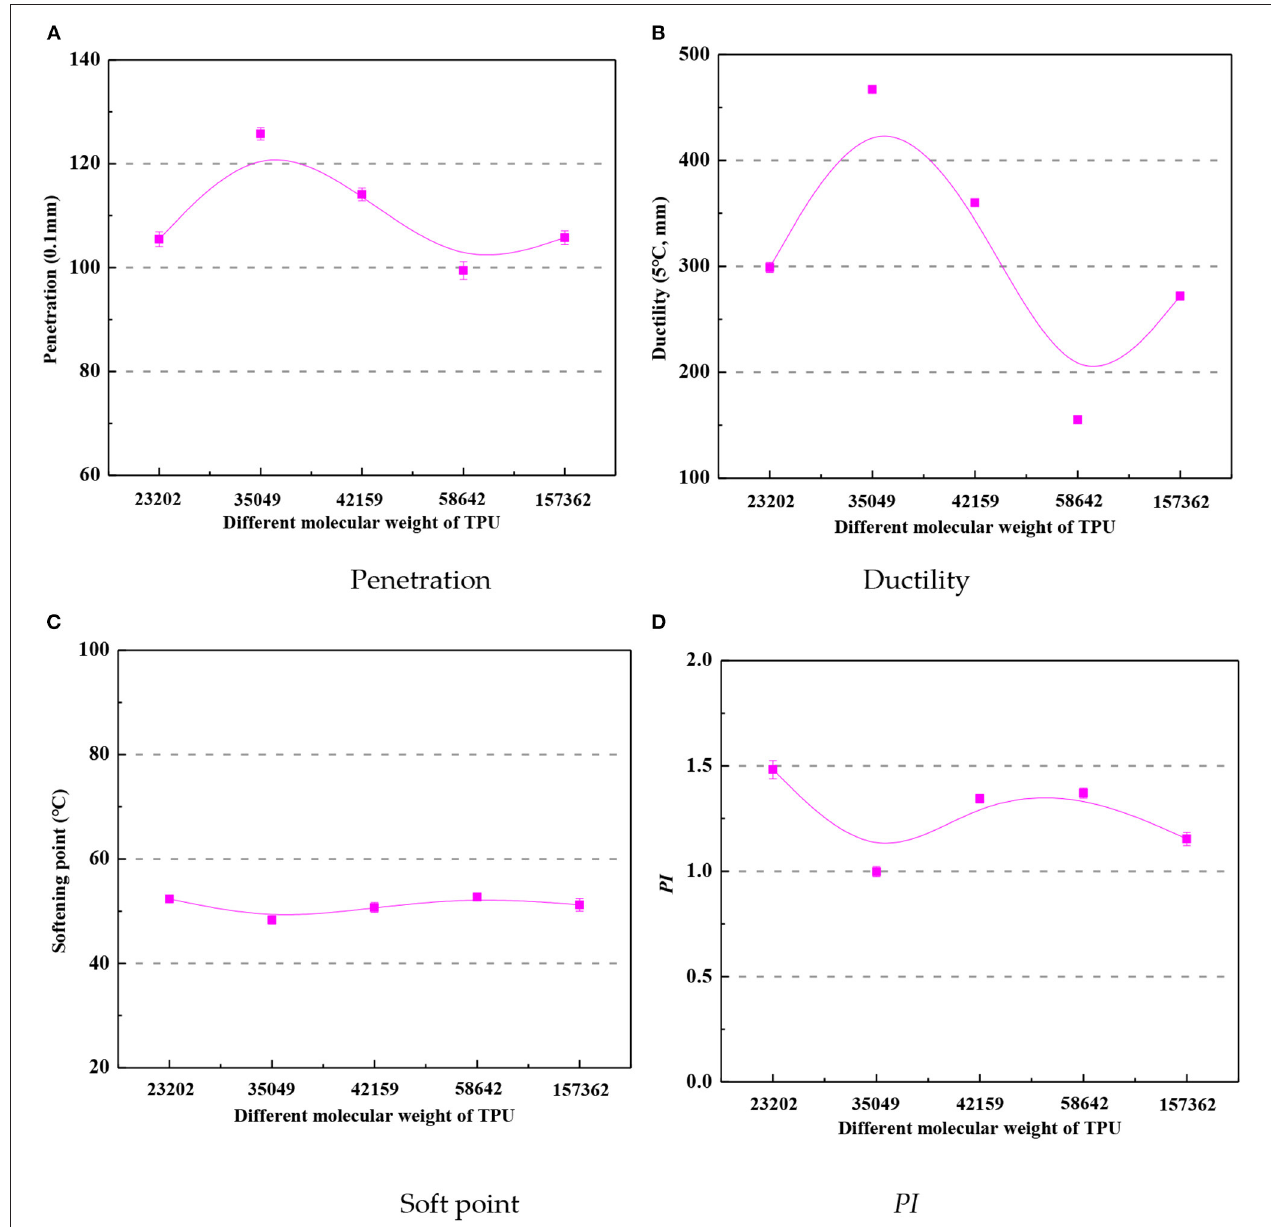
FIGURE 14 | Polyether-based TPU-modified asphalt. (A) Penetration. (B) Ductility. (C) Soft point. (D) PI